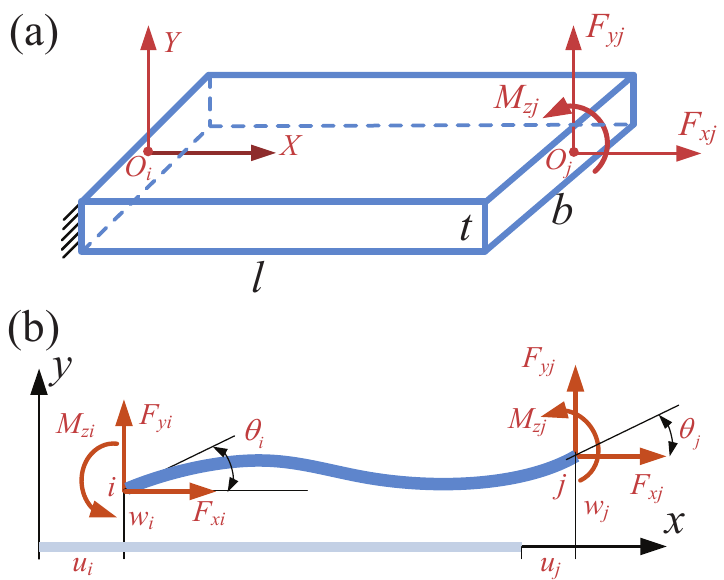
Figure 2. Model and deformation of a beam flexure. ( a ) The model of a fixed–free beam structure. ( b ) The model of a free–free beam